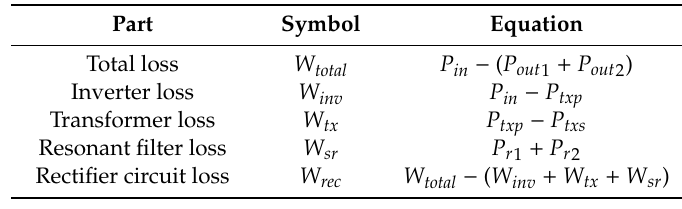
Table 6. Loss calculations.